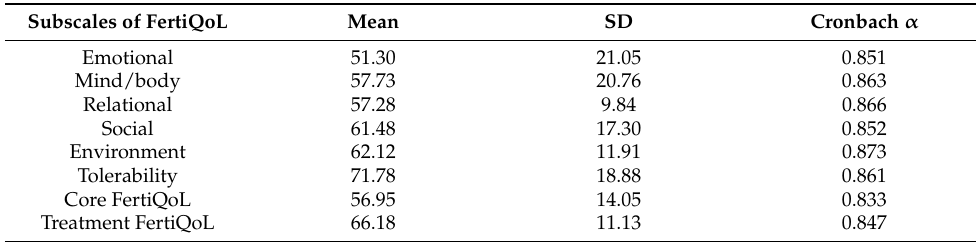
Table 2. FertiQoL scores and α -Cronbach’s